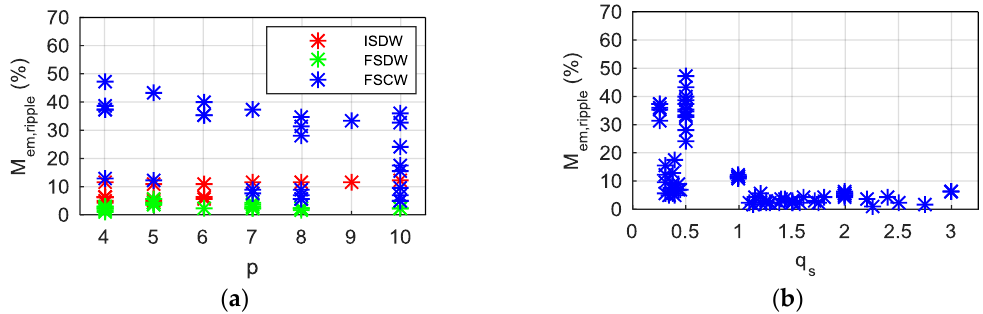
Figure 14. Torque ripple ( M em,ripple ) versus ( a ) pole pair number ( p ) and winding type; ( b ) stator slot number per pole and phase ( q s ).